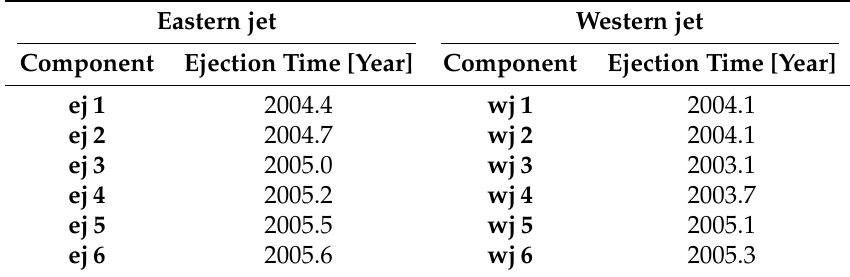
Table 2. Ejection times of jet components ej1 to ej6 and wj1 to wj6. The errors on the ejection times are typically ∼ 0.1